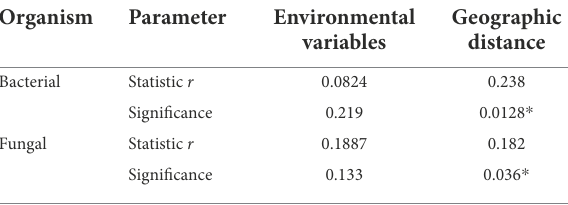
TABLE 5 Spearman rank correlations ( r values) of microbial community composition with matrices of environmental variables and geographic distance based on Mantel